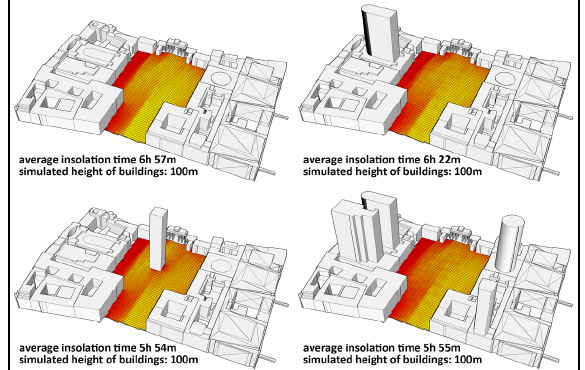
Figure 11. Public space insolation patterns in existing and simulated urban structure around Pariser Platz in